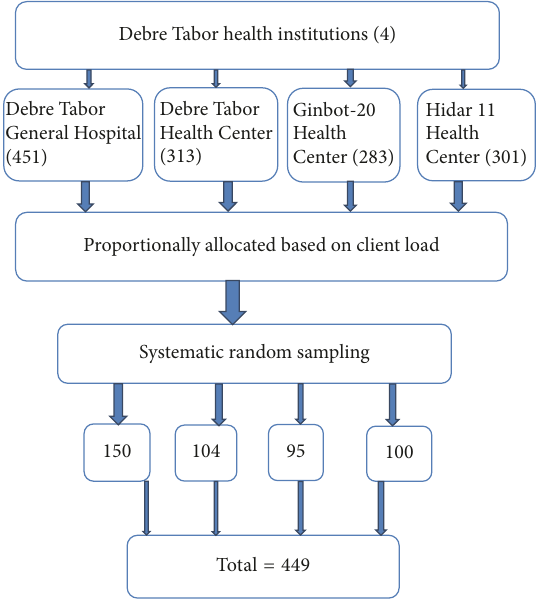
Figure 2: Schematic presentation of sampling procedure for early Implanon discontinuation and associated factors in Debre Tabor town public health facilities, South Gondar Zone, Amhara Region,